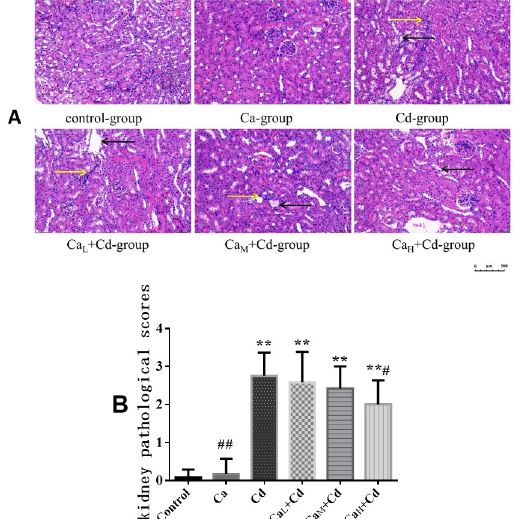
Fig 6. The pathological sections (A) and pathological scores (B) of kidneys in different groups. (A) Pathological sections of kidneys. Pictures were taken at 200 × magnification and the bar indicates 500 μ m. Yellow arrows indicate inflammatory cell infiltration, and black arrows indicate transparent casts. (B) Kidney pathological scores. The data are shown as mean ± SD. � P < 0.05, compared with control-group. �� P < 0.01, compared with control-group. # P < 0.05, compared with Cd-group. ## P < 0.01, compared with